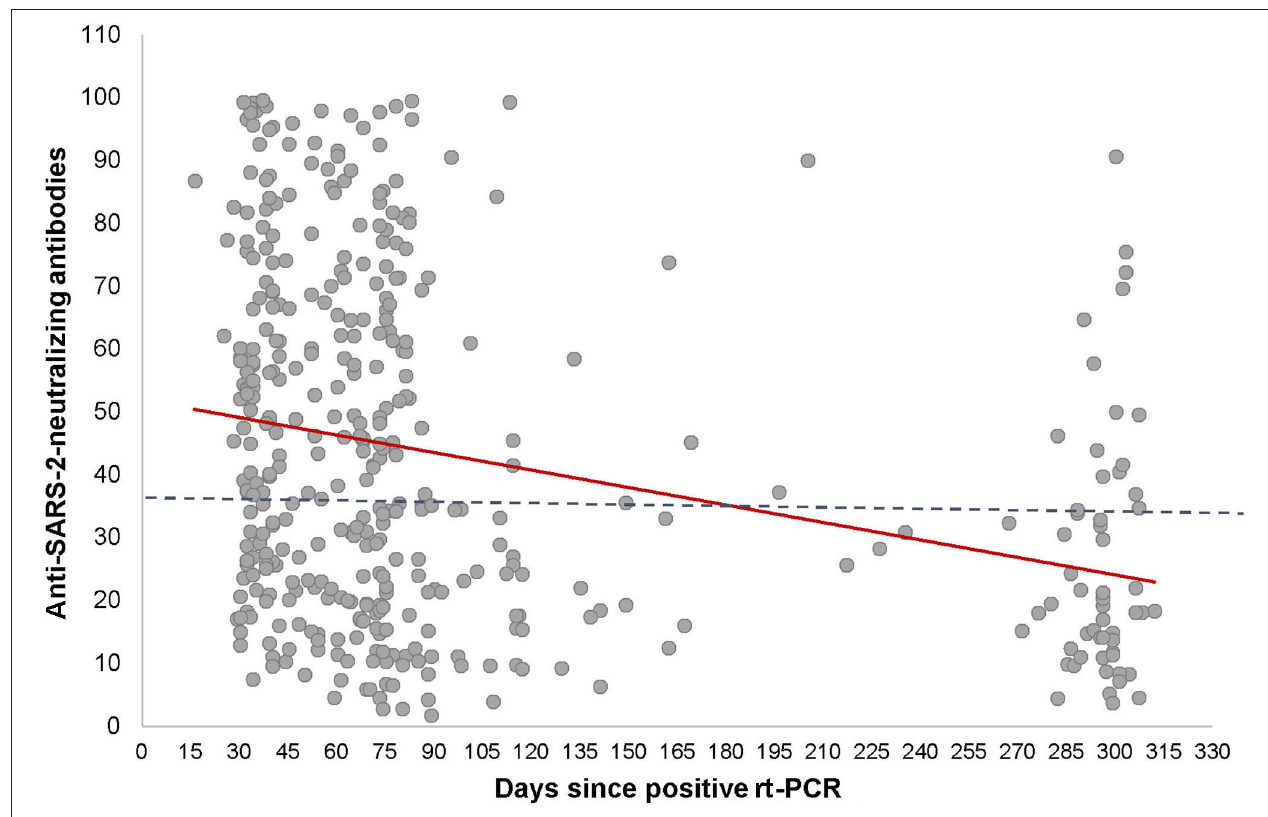
FIGURE 2 | Correlation between anti-SARS-CoV-2-neutralizing antibodies and time after COVID-19 infection. Cross-sectional representation for anti-SARS-CoV-2-neutralizing levels at different time-points for 412 individuals. Each black dot represents one participant and the anti-SARS-CoV-2-neutralizing levels. The red line represents the interpretation line, which shows the negative linear association between the anti-SARS-CoV-2-neutralizing level and the days passed since the diagnosis of COVID-19. The dotted line represents the reference line for the cut-off for having anti-SARS-CoV-2-neutralizing antibodies, which is set at